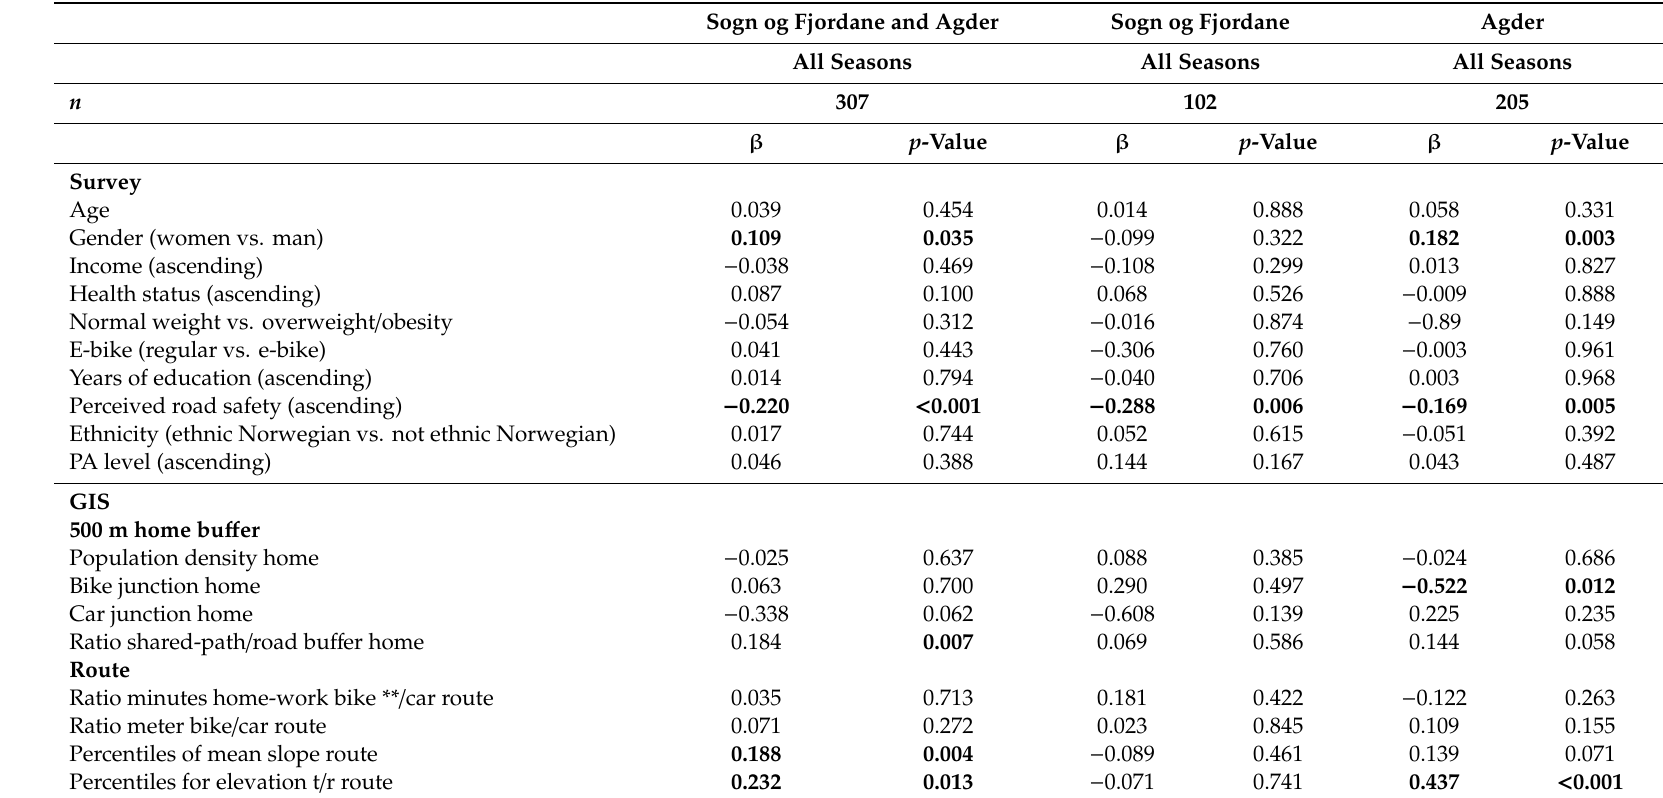
Table A3. Linear regression of distance * cycled. Significant associations are written in bold. Sogn og Fjordane and Agder Sogn og Fjordane Agder All Seasons All Seasons All Seasons